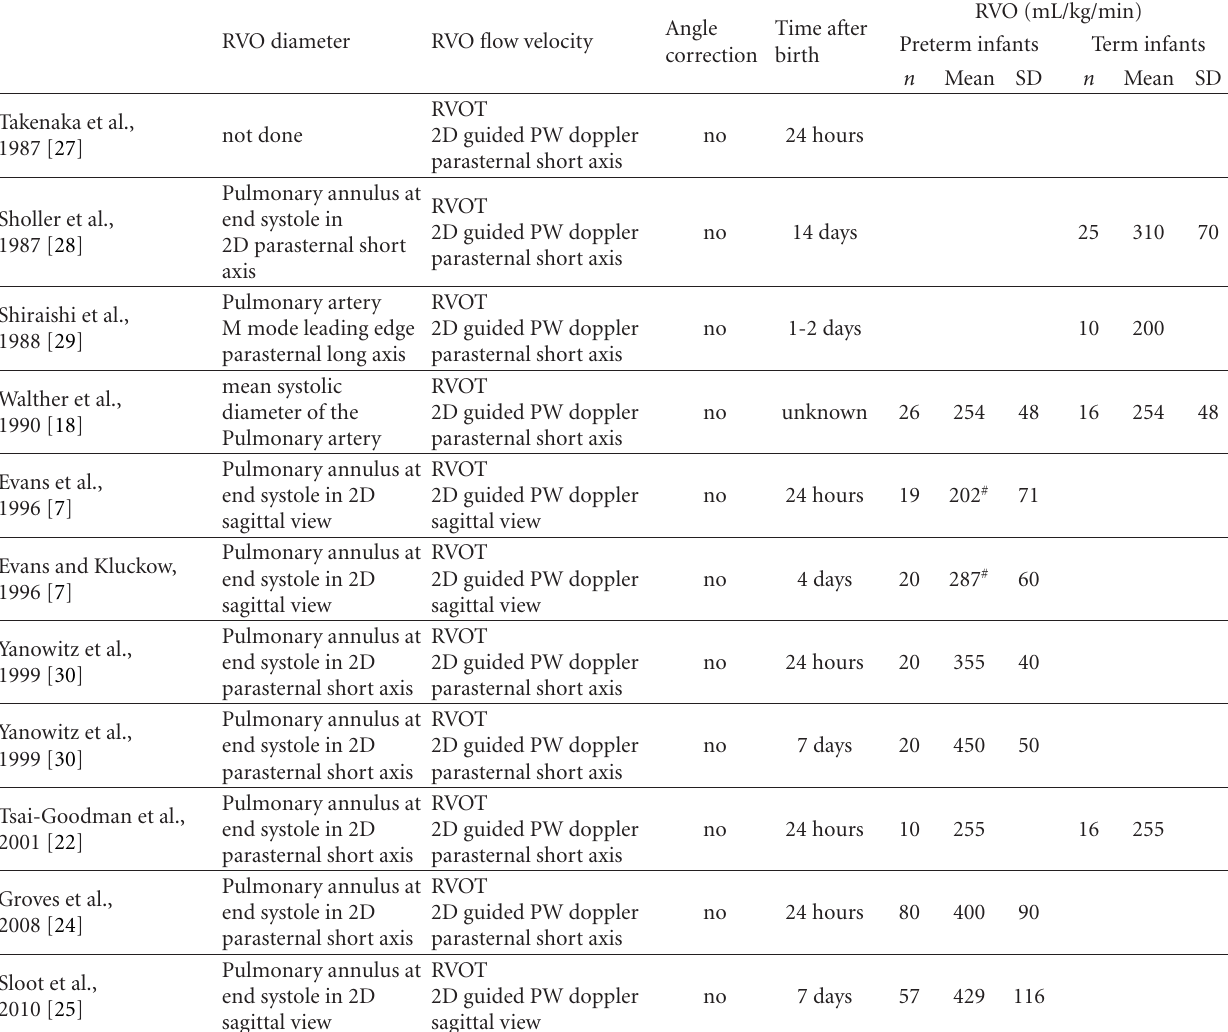
Table 2: Methods of determination of RVO diameter, flow velocity, and reported mean (SD) values in